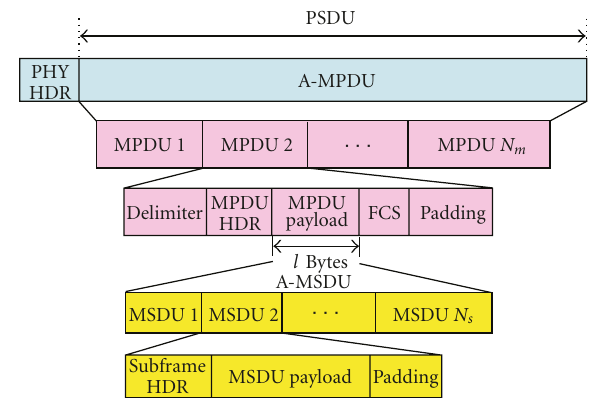
Figure 1: The schematic diagram of A-MPDU and A-MSDU frame